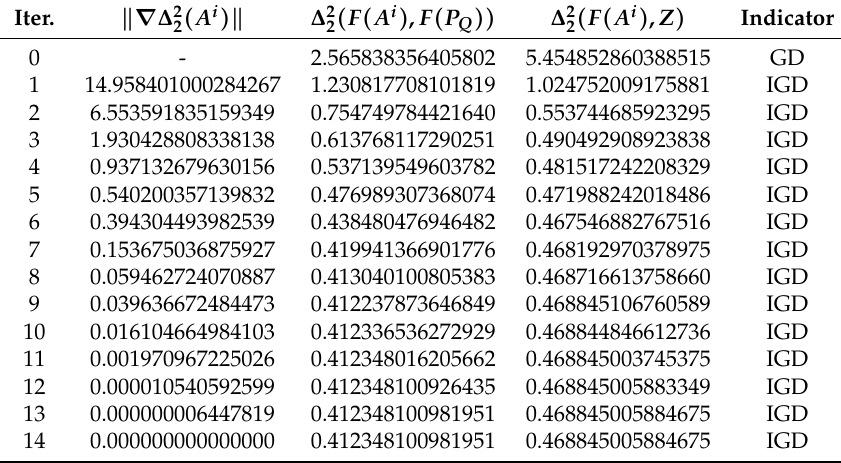
Figure 16. Different iterations of the ∆ 2 bootstrapping method. Table 10. Numerical results of the ∆ 2 bootstrapping